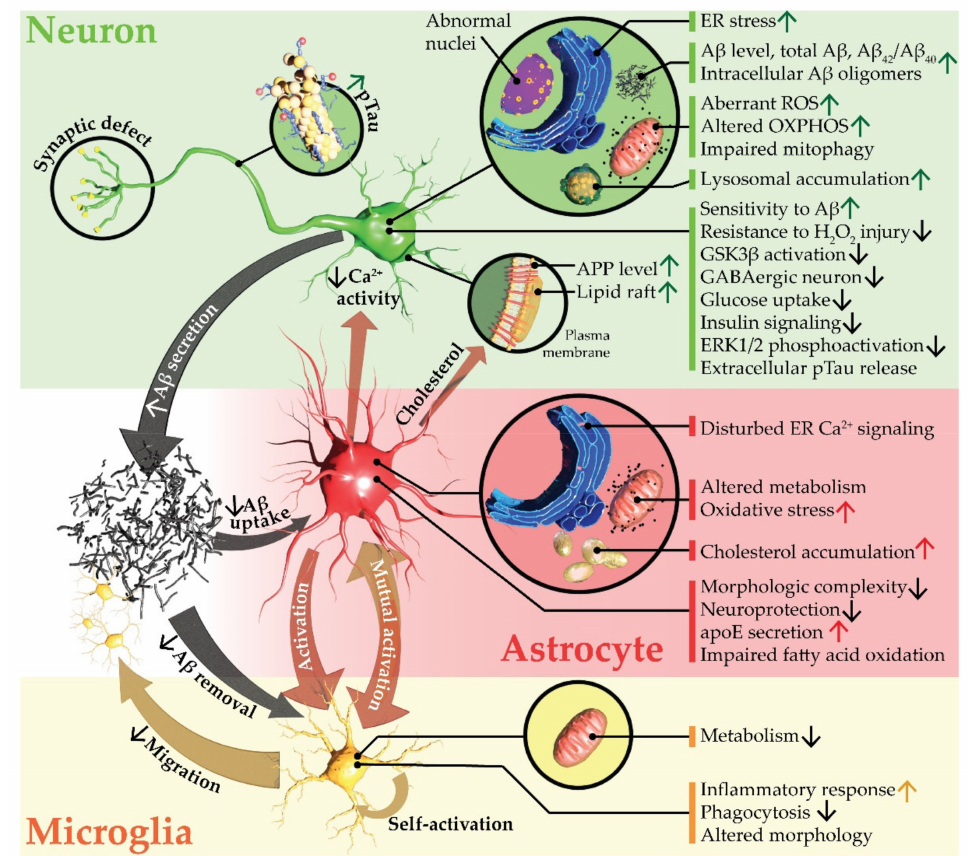
Figure 1. Alzheimer’s disease phenotypes captured in human induced pluripotent stem cell–derived 2-dimensional models. A β , amyloid- β ; apoE, apolipoprotein E; APP, amyloid precursor protein; Ca 2+ , calcium ion; ER, endoplasmic reticulum; ERK1/2, extracellular signal-regulated kinases 1 and 2; GABAergic, G -aminobutyric acid–mediated; GSK3 β , glycogen synthase kinase-3 β ; H 2 O 2 , hydrogen peroxide; OXPHOS, oxidative phosphorylation; pTau, phosphorylated tau; ROS, reactive oxygen